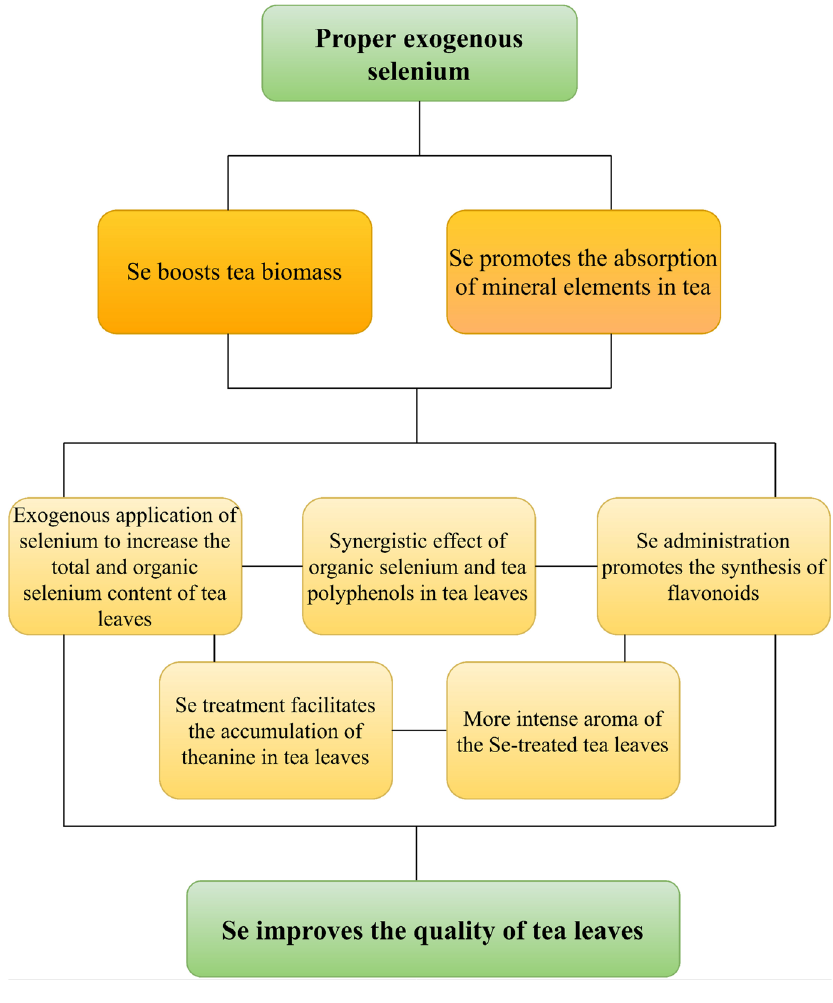
Figure 3. Proper exogenous selenium improves the biomass and nutritional quality of tea plants.